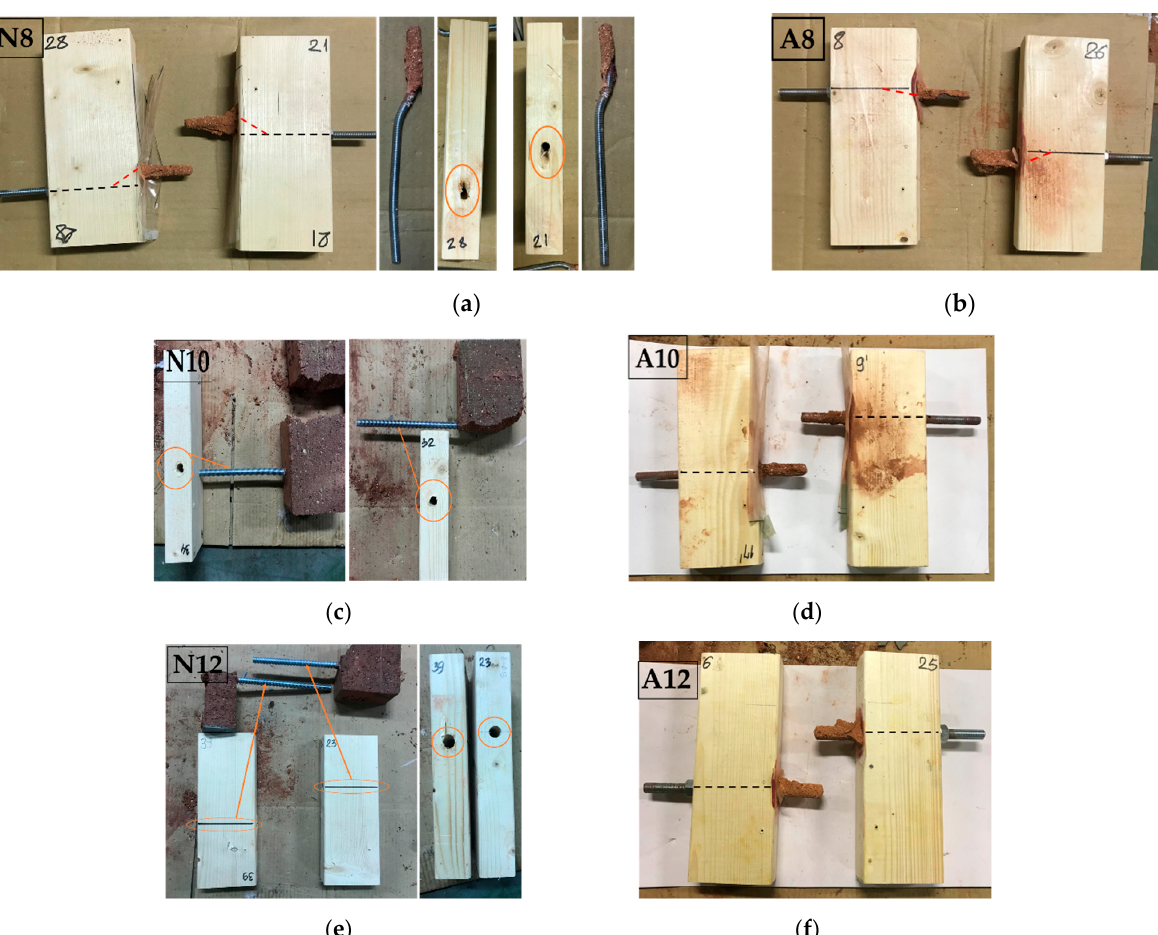
Figure 14. Deformation of bolt and hole of wood (side member). ( a ) N8-1 specimen; ( b ) A8-1 specimen; ( c ) N10-2 specimen; ( d ) A10-2 specimen; ( e ) N12-3 specimen; ( f ) A12-2 specimen.